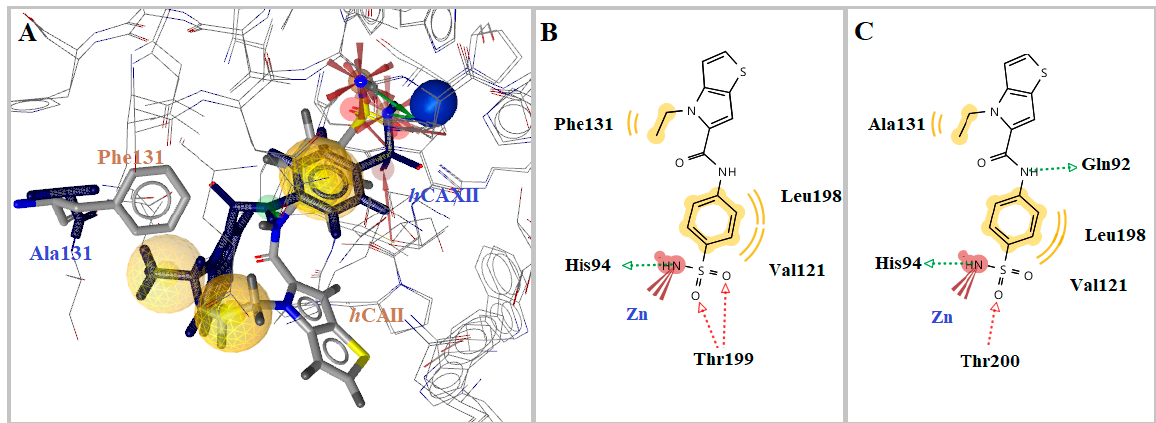
Figure 4. ( A ) Superposition of compound 8b bound to hCA II (grey) in comparison to hCA XII (blue), with specific residues labeled, ( B ) 2D interaction diagram of compound 8b docking pose interactions with the key amino acids in hCA II and ( C ) in hCA XII. Active site zinc is shown as a blue sphere, red dotted, and green arrows indicate H-bond and yellow spheres hydrophobic